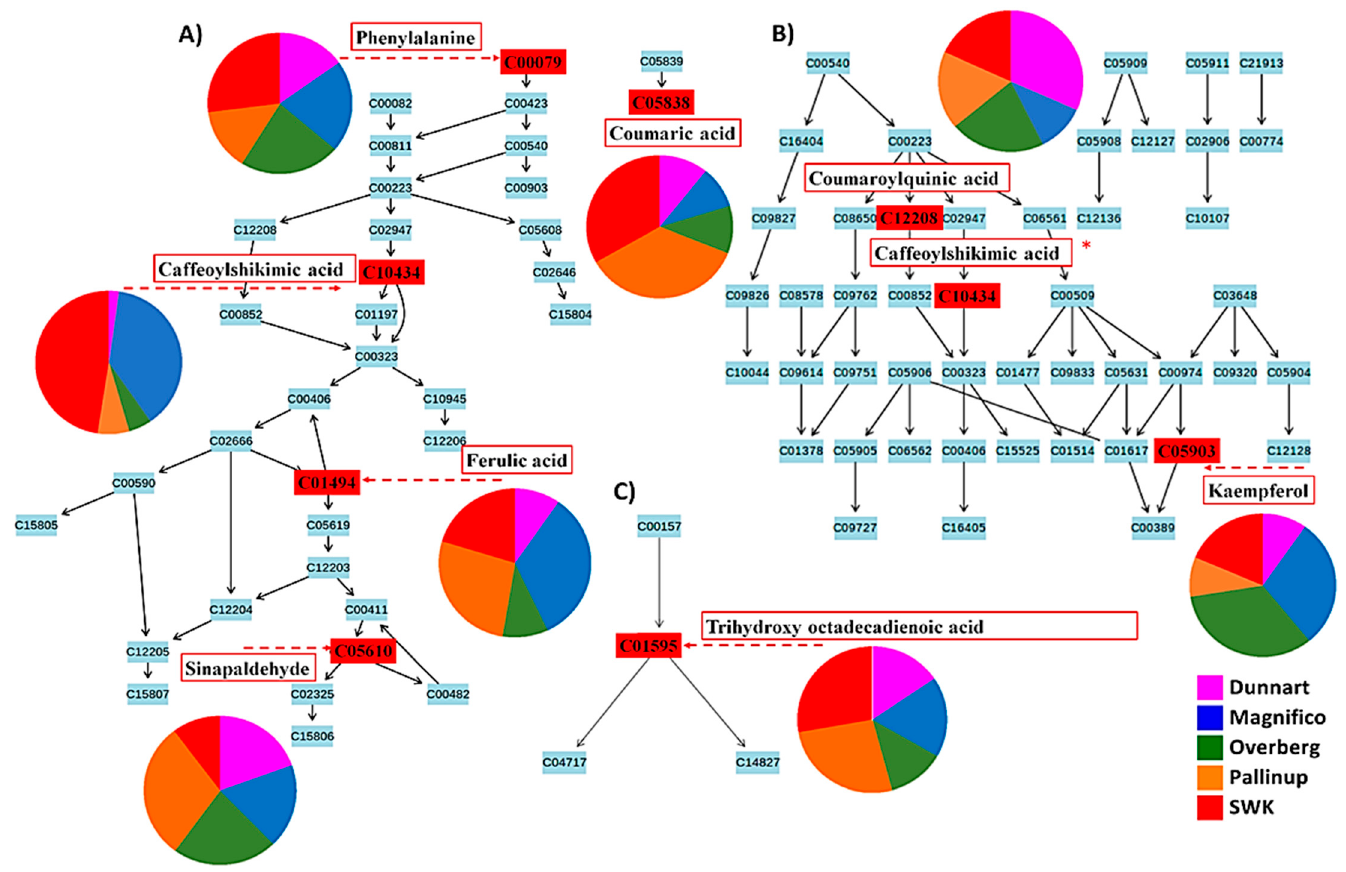
Figure 10. Pathways flagged from metabolomics analysis using MetaboAnalyst software. Signatory metabolites involved in each pathway are illustrated in the form of a pie chart according to their relative intensities and presence across the different cultivars. ( A ) Phenylpropanoid pathway, ( B ) flavonoid pathway overlapping with the phenylpropanoid pathway (*) and ( C ) linoleic acid pathway that showed the highest impact after pathway enrichment analysis. Some limitations in MetaboAnalyst prevented the mapping of all annotated metabolites (Table 1). The respective metabolite codes (e.g., C00079-Phenylalanine) indicate KEGG unique identifiers.